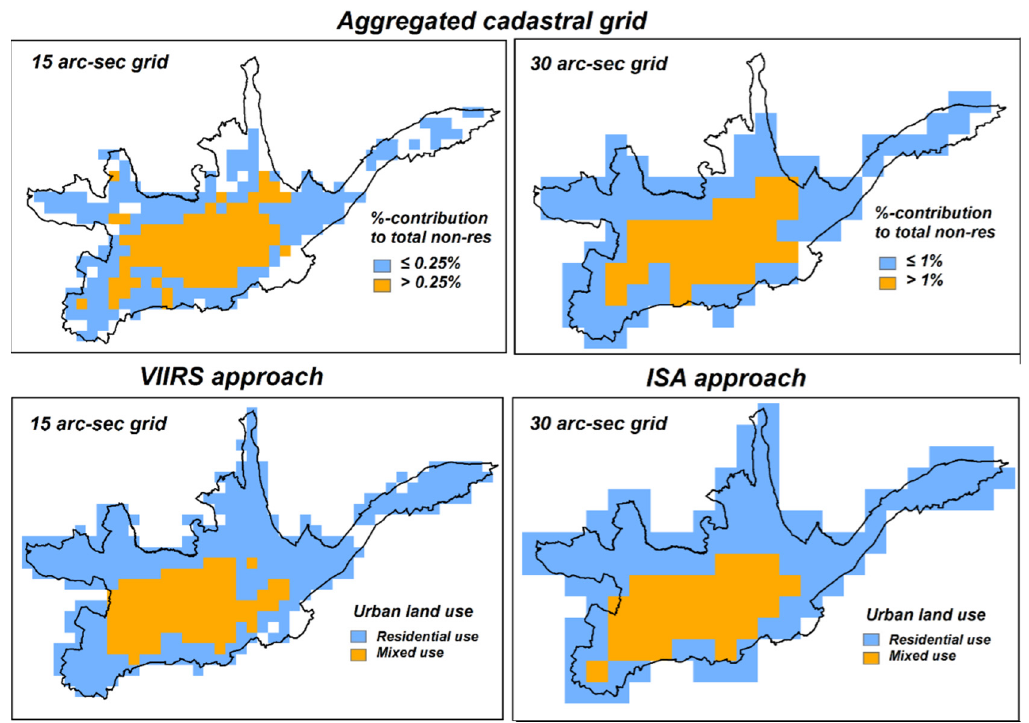
Figure 11. Binary classification of the non-residential cadastral built-up area aggregated to 15 arc-sec ( top - left ) and 30 arc-sec grids ( top - right ) based on the percent-contribution to the total non-residential area of Cuenca City. Best-matching binary classifications as derived from 15 arc-sec VIIRS ( bottom - left ) and 30 arc-sec ISA ( bottom - right ) data.